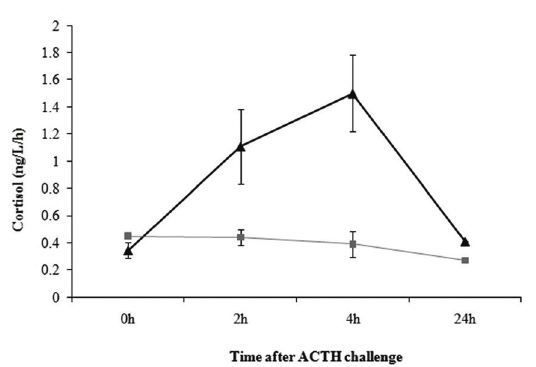
Fig. 10. Temporal variation (mean and SEM) of cortisol lev- els in holding-water Moenkhausia bonita challenged with an intra-peritoneal injection of porcine ACTH. Triangles, darker line = ACTH; squares, lighter line = RINGER (control).